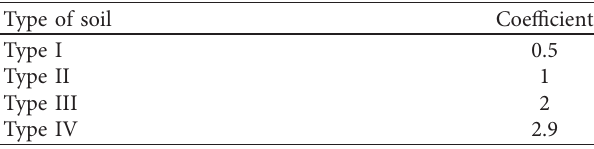
Table 5: Weighted coefficient for conditions of the ground.